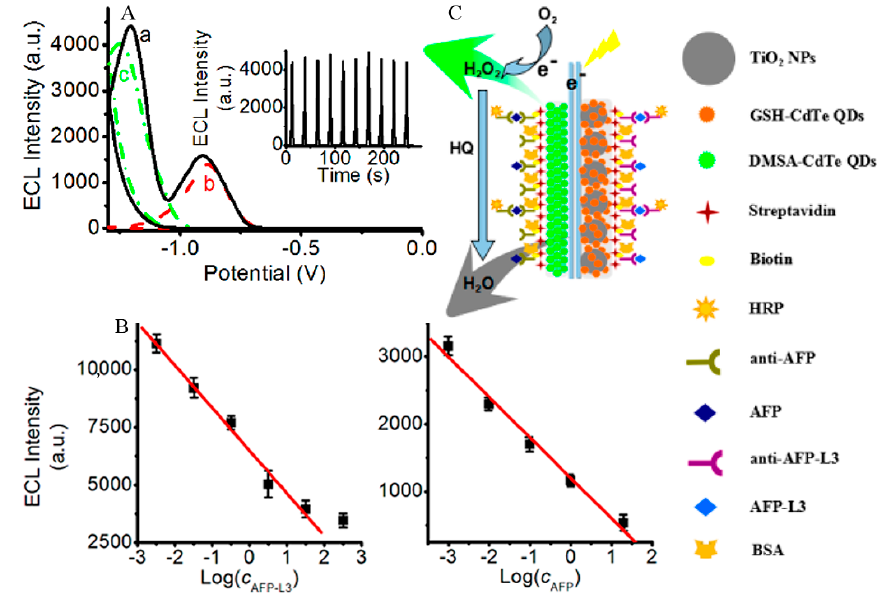
Figure 8. ( A ) ECL curves of simultaneous scan of DMSA-CdTe QDs and TiO 2 -GSH-CdTe QD composites; individual scan of (a) DMSA-CdTe QDs, (b) TiO 2 -GSH-CdTe QD composites, and (c) modified ITO electrodes. Inset: Continuous cyclic simultaneous scans of DMSA-CdTe QDs and TiO 2 -GSH-CdTe QD composites modified ITO electrodes. ( B ) Linear calibration plots for detection of AFP-L3 (left) and AFP (right). ( C ) Sandwich immuno-structure of HRP-labeled antibody–antigen biotinylated antibody on the immunosensor and detection procedures of analytes (green arrow: luminescence; gray arrow: quenching). Reproduced from [66] with permission from the American Chemical Society.